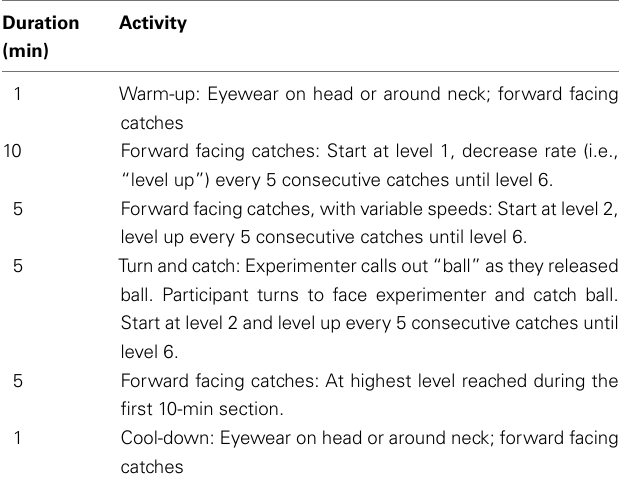
Table 2 |Twenty-seven minute in-lab training